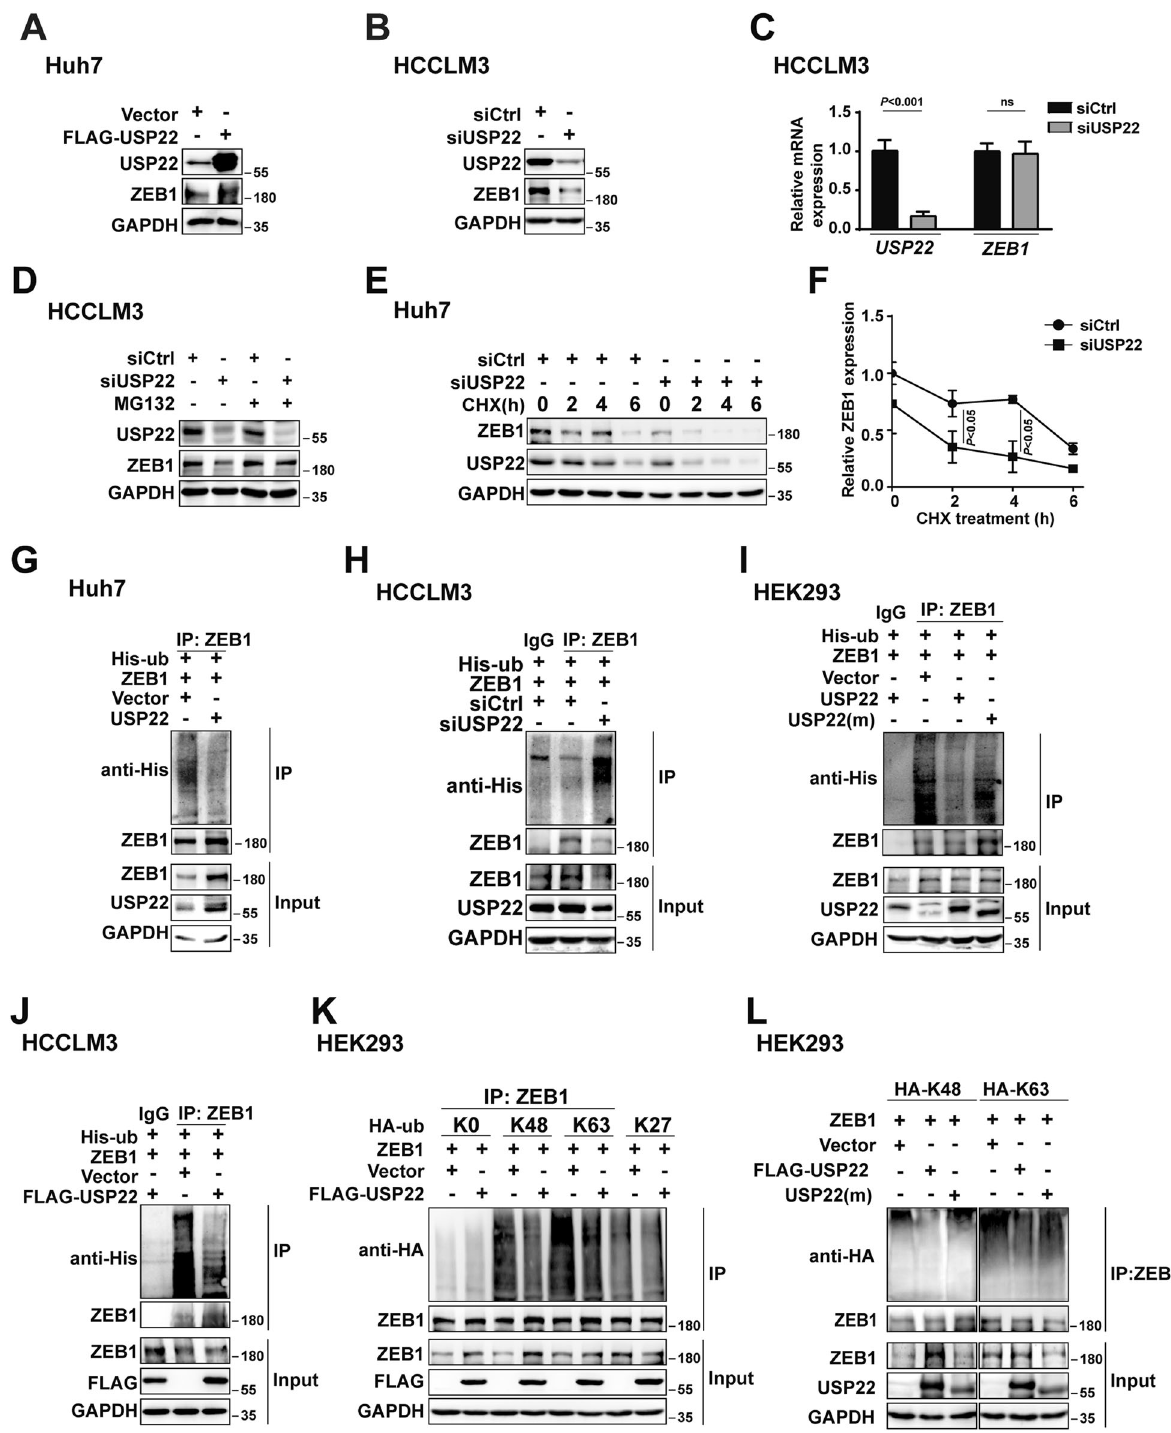
Our data indicate that USP22 promotes cell proliferation in HCC cells and the effect of USP22 on cell growth is partially related to VEGFA. We observed that USP22 knockdown resulted in morphological atrophy of HCC cells and enhanced cell-to-cell adhesion to be dif fi cult to form association between cell colonies (Fig. 5D). These results suggest that USP22 may participate in matrix remodeling or movement of HCC cells. Vasculogenic mimicry (VM)